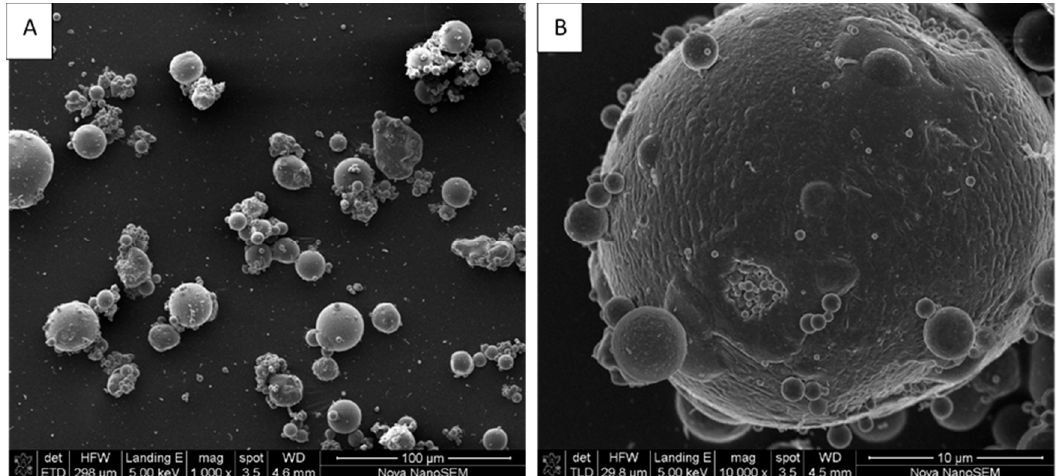
Figure 2. SEM micrographs of coal fly ash particle sizes were taken at the magnification of ( A ) 1000×, and ( B ) 10,000× .